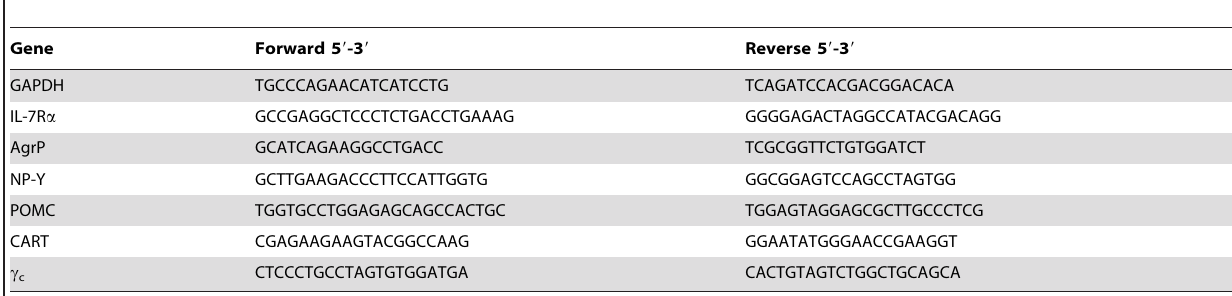
Table 1. Primer sequences used for real-time